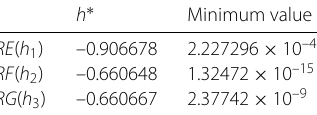
), RF ( h ∗ ), RG ( h ∗ ) (see Figs. 1 2 3